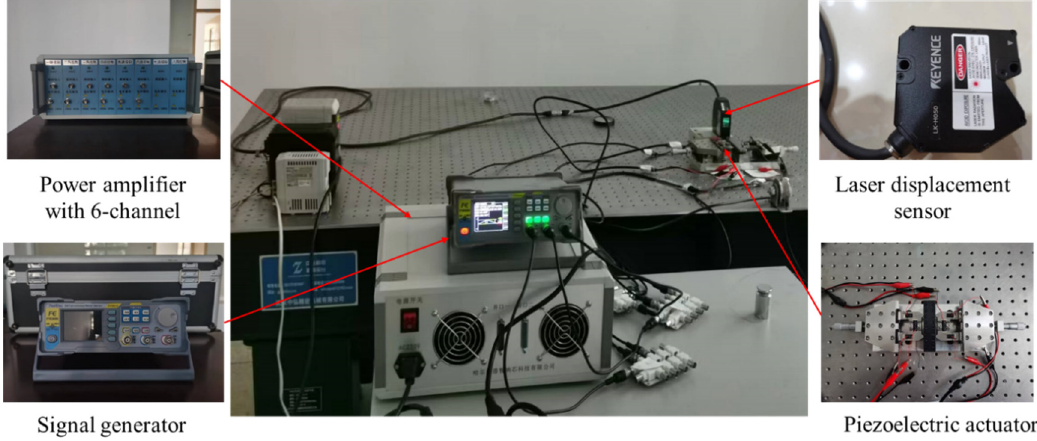
Figure 8. Experimental platform of the piezoelectric actuator.